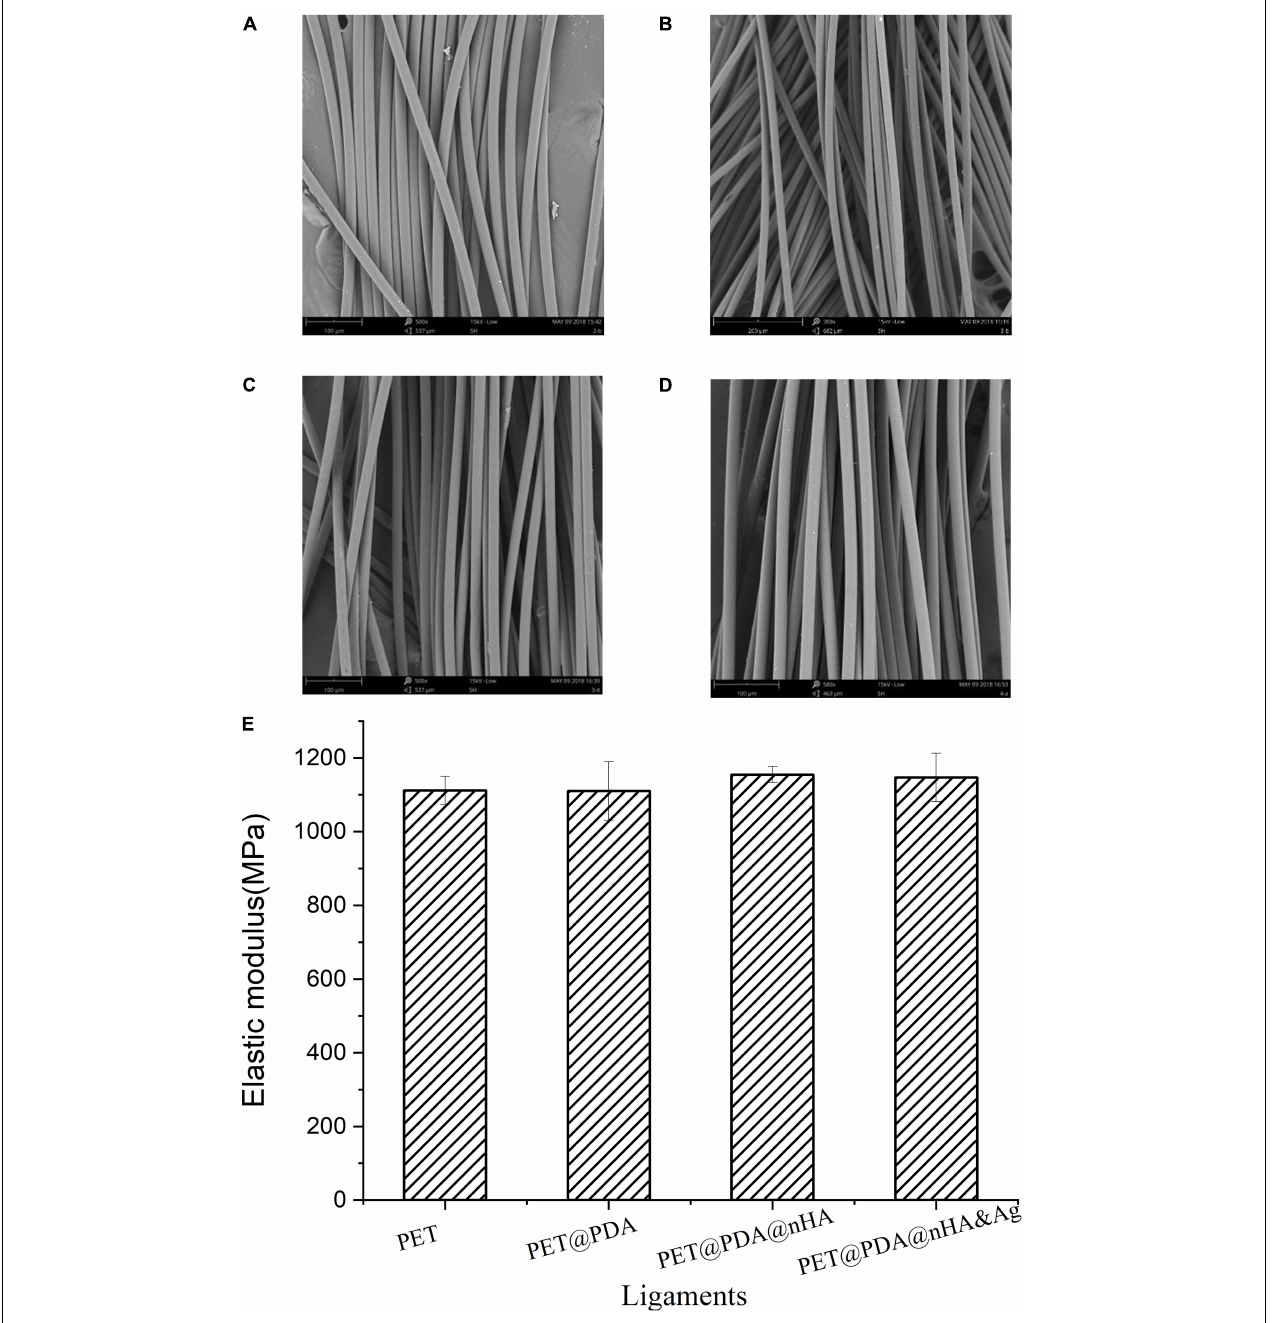
FIGURE 7 | SEM images of PET (A) , PET@PDA (B) , PET@PDA@nHA (C) , and PET@PDA@nHA&Ag (D) ligament fibers and (E) the elastic modulus of the four ligaments.